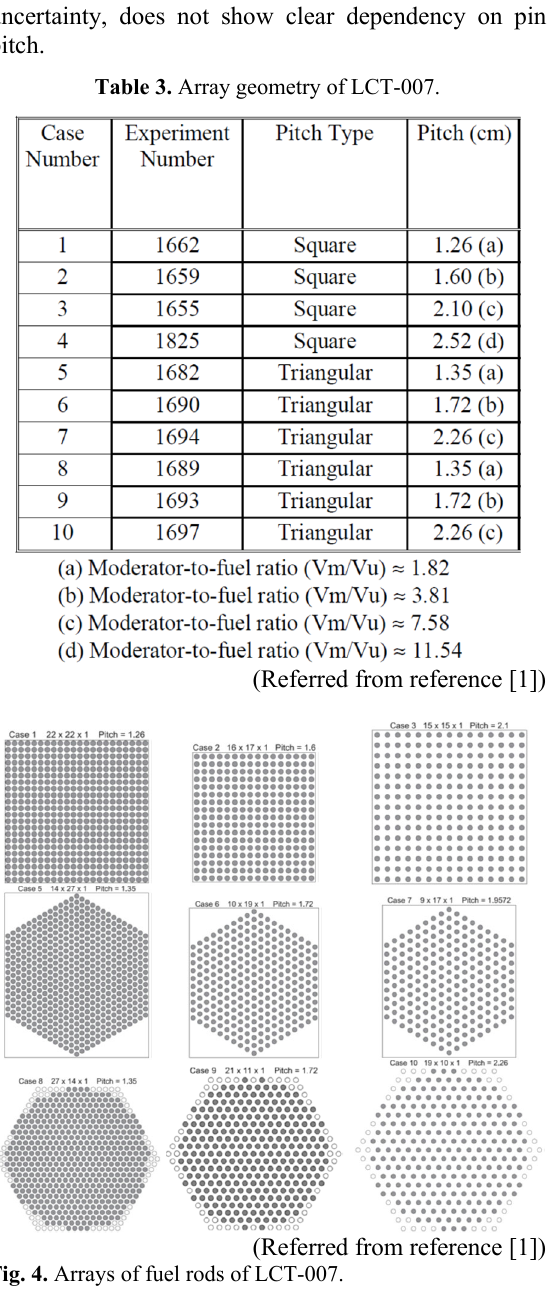
Fig. 4. Arrays of fuel rods of LCT-007.